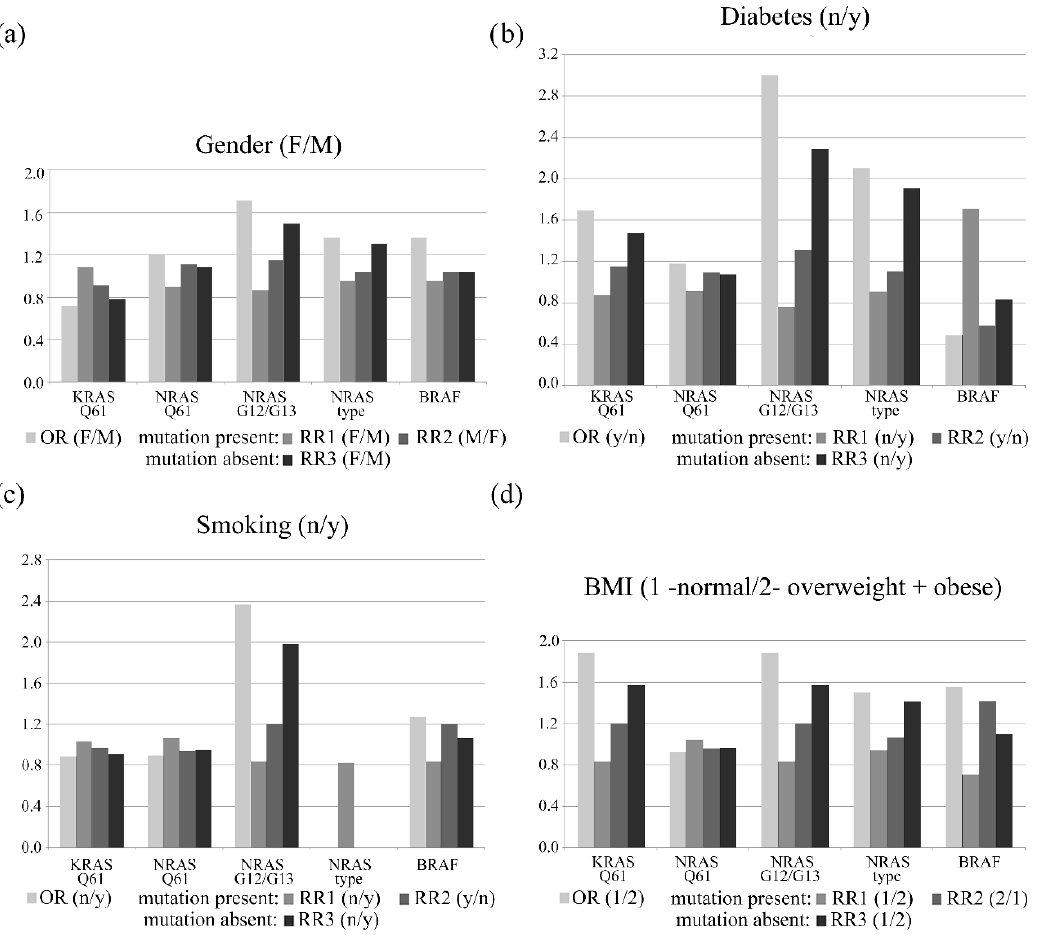
Figure 2. The association of the variables gender ( a ), diabetes ( b ), smoking ( c ), and BMI ( d ) with the presence of different mutation types illustrated by the values OR, RR1, RR2, and RR3 calculated for all possible combinations.